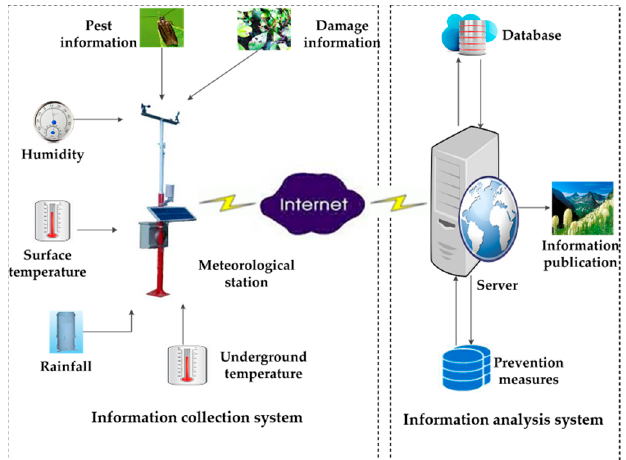
Figure 1. The components of agricultural monitoring service platform.